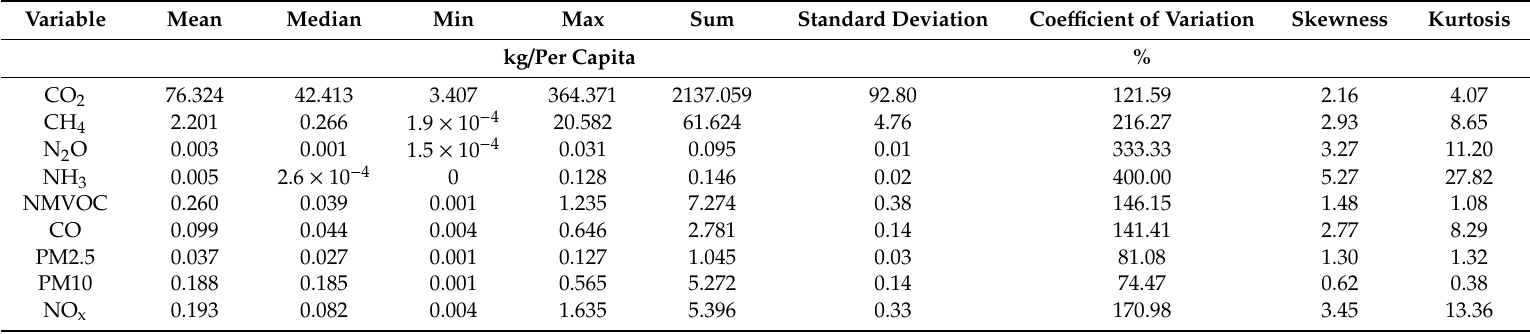
Table 6. Basic statistical parameters of the emissions of studied substances in relation to the population of the EU countries (own elaboration). Variable